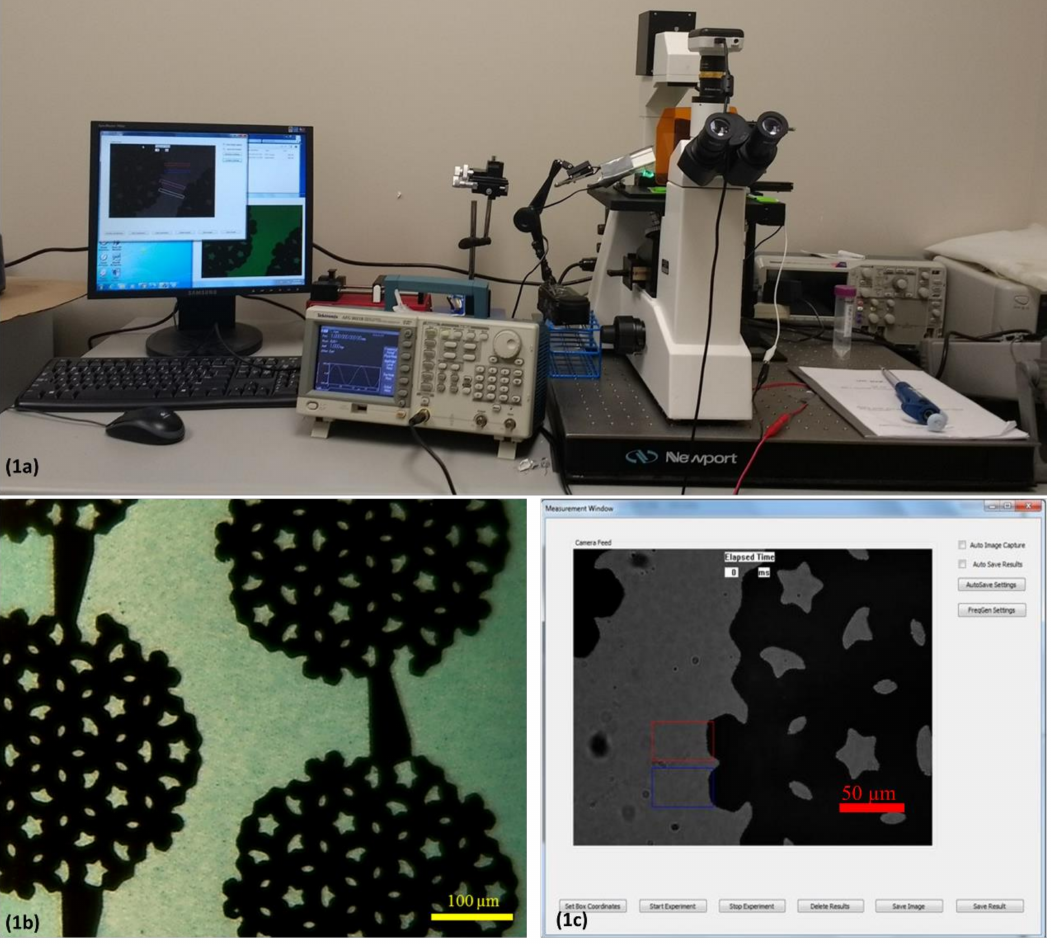
Figure 1. ( a ) Experimental setup of the sensor prototype. ( b ) Interdigitated electrode used in the experiments. The electrode is visible as the darker region in the picture. Scale bar indicates 100 µ m. Multi-colored hollow rectangles depict the regions of interest for measurements and analysis. ( c ) Interface of Microsoft Windows application for dielectrophoresis (DEP)